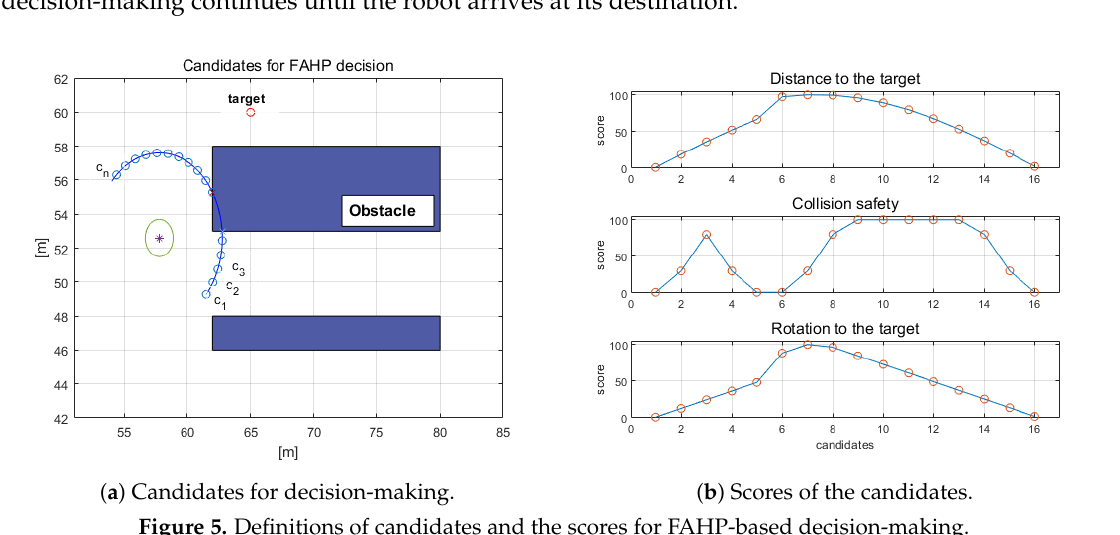
Figure 5. Definitions of candidates and the scores for FAHP-based